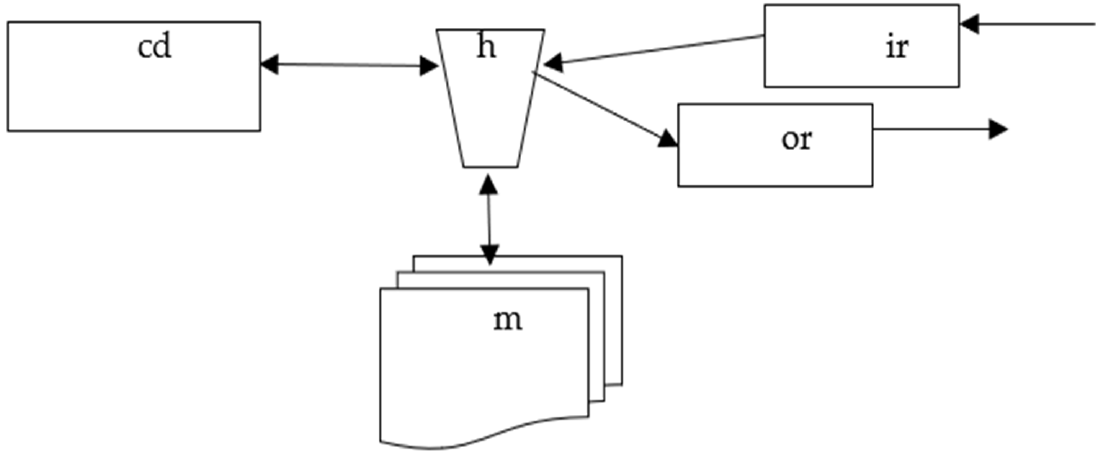
Figure 4. A schema of an inductive Turing machine.